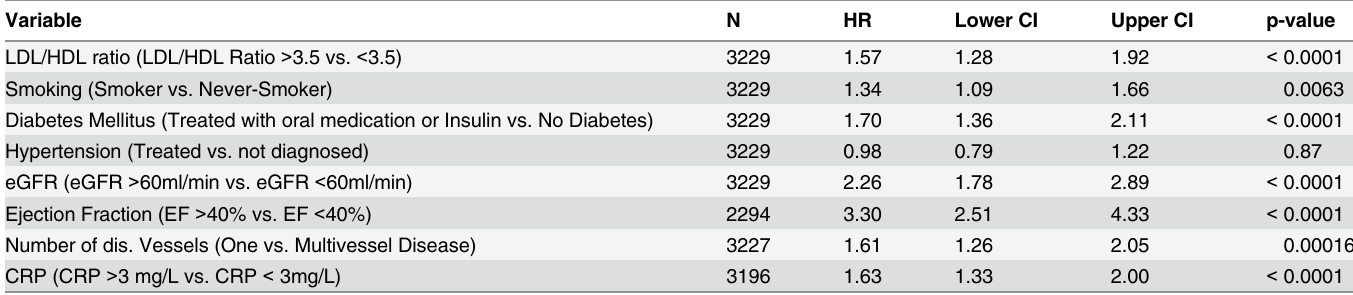
On top of the traditional risk factors age and sex (C-index 0.58 and 0.59 in SAP), each risk factor alone improved the C-Index with exception of arterial hypertension ( Table 4 for the overall cohort and Table 5 for the SAP cohort). The traditional risk factor with the highest influence was diabetes mellitus with a C-index of 0.6 (0.61 in SAP), showing the best improve- ment of all traditional risk factors in both the overall and SAP cohort. Combining all traditional risk factors with age and sex (C-index 0.62 and 0.63 in SAP), these clinical variables increased the C-index additionally. In the overall cohort C-index for renal function, CRP and ejection fraction were all 0.64 and 0.63 for multivessel disease. In the SAP cohort, the highest C-index was shown for renal function with 0.66, followed by CRP with 0.65 and equally ejection frac- tion and multivessel disease with 0.64.In all, the highest C-index was achieved upon adding the traditional risk factors and the clincial variables to age and sex showing a C-index of 0.66 in the Table 2. Cox Proportional Hazard Regression in the overall cohort (N = 3229). Overall Cohort (N = 3229).